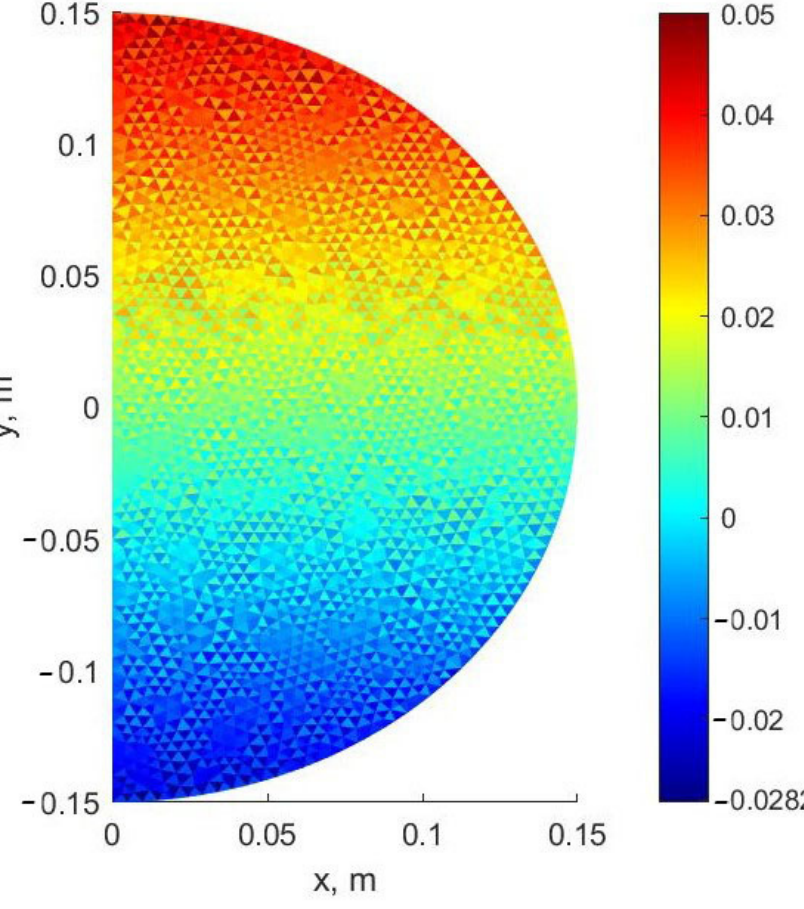
Figure 8. Mosaic of stresses σ y (MPa) for the finer FE mesh in MATLAB. Also, the developed methodology and software was tested on experimental data presented in the works of A.L. Krishan and A.I. Sagadatov [31–33]. The comparison with the experimental data for two series of columns with an outer diameter of the concrete core of 159 and 219 mm and wall thickness of 6 and 8 mm, can be introduced respectively. Table 2 presents the experimental values of the ultimate loads N u ,exp , the theoretical values N u , theor were obtained, as well as the values of the ultimate loads N u , bs , calculated without taking into account the lateral compression of the